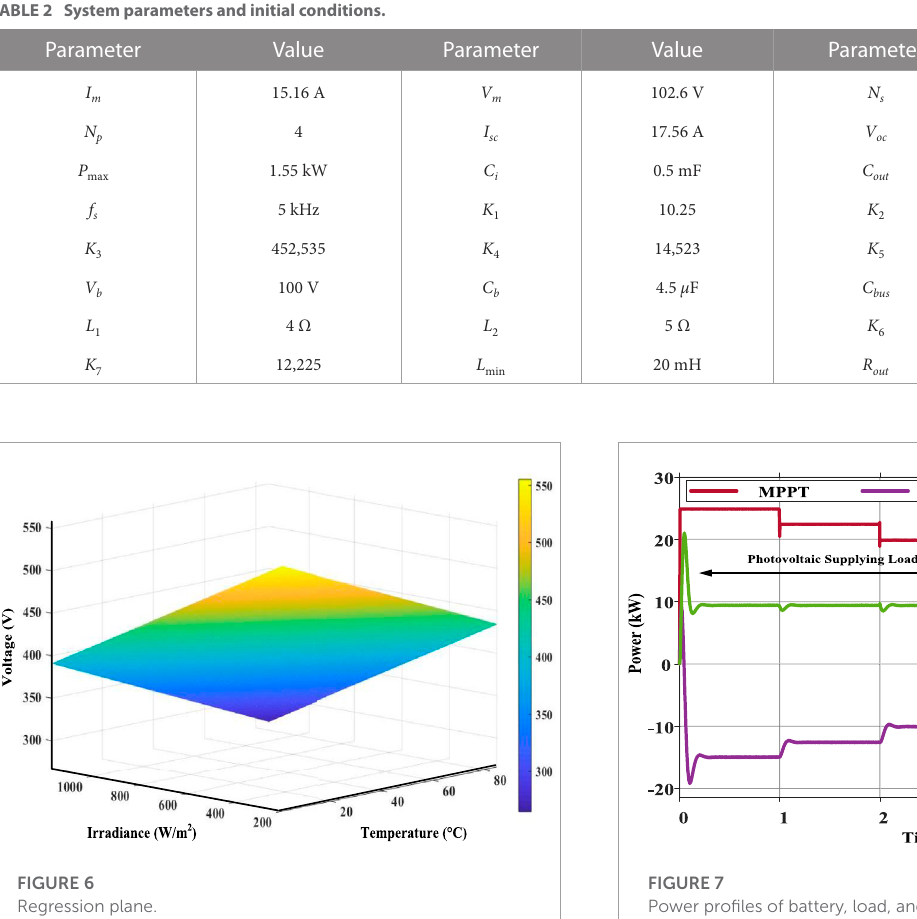
FIGURE 7 Power profiles of battery, load, and